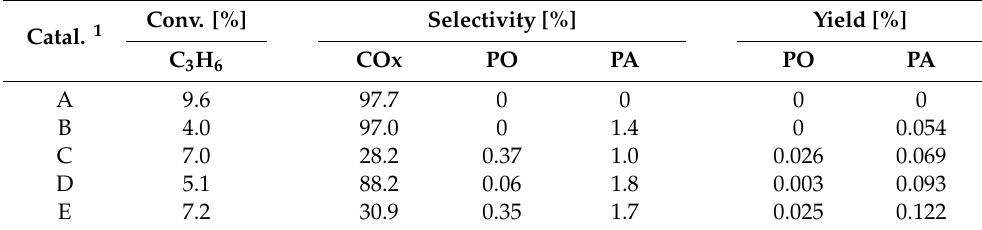
Table 1. Catalytic activities on MCM-41 and related catalysts.